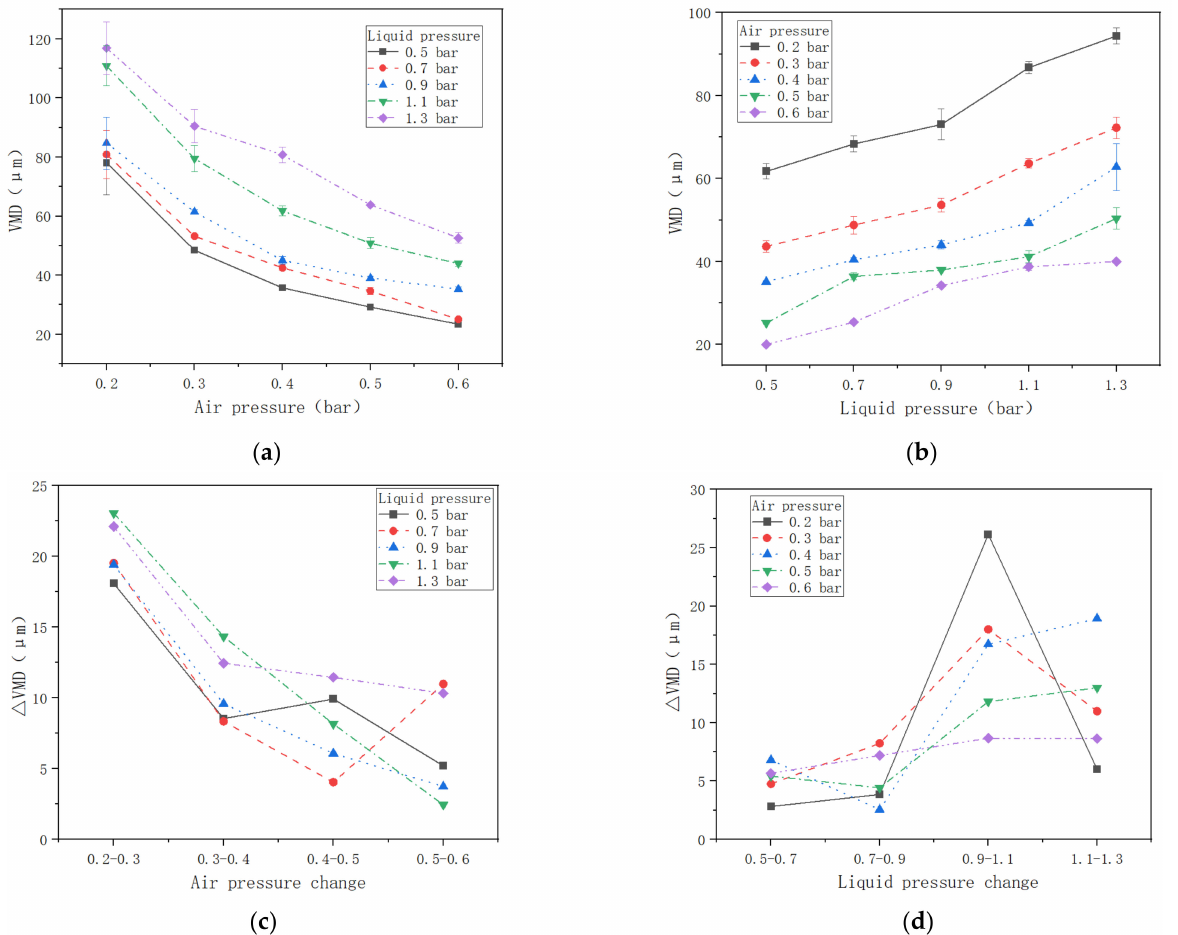
Figure 5. ( a ) VMD variation with air pressure when the applied voltage is 0 kV, ( b ) VMD variation with liquid pressure when the applied voltage is 3 kV, ( c ) ∆ VMD variation with air pressure change when the applied voltage is 3 kV, ( d ) ∆ VMD variation with liquid pressure change when the applied voltage is 0